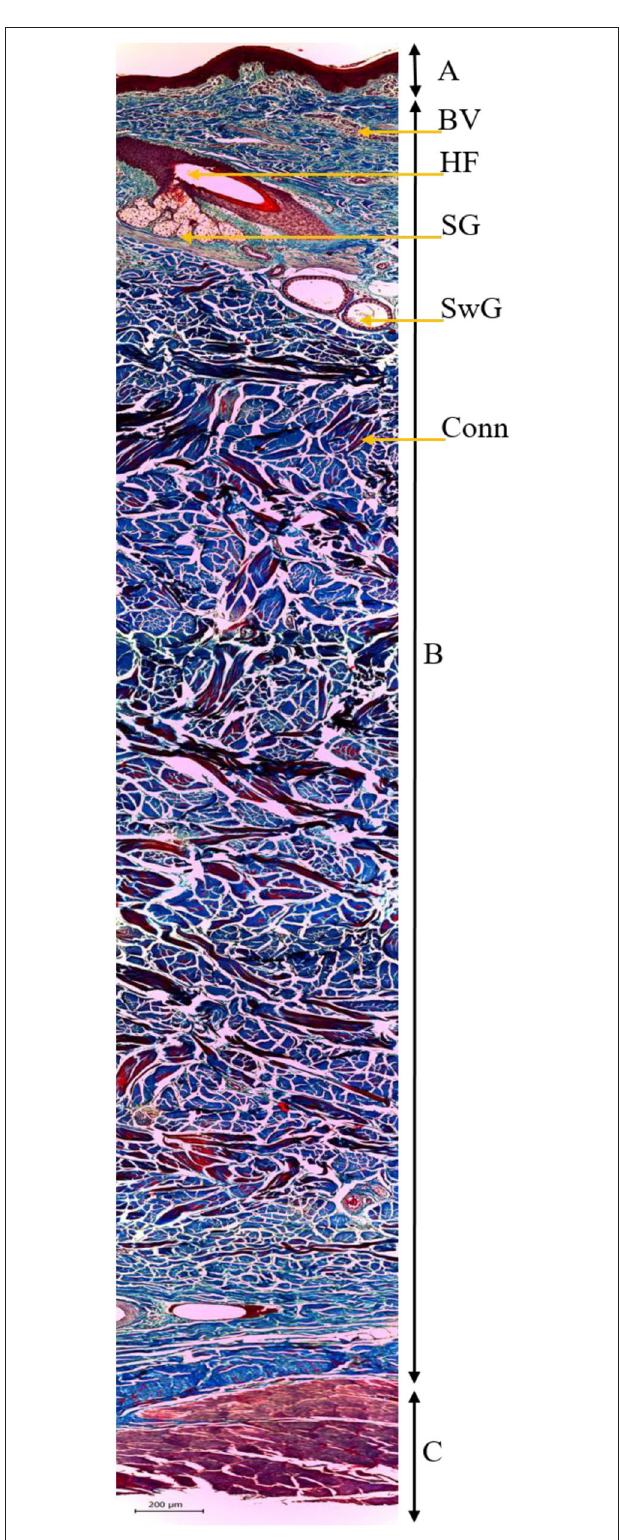
FIGURE 3 | Histological image of the skin of buffaloes ( B. bubalis ) stained by Mason’s trichrome, assessed in light-field optical microscopy (100 × ): epidermis (A) , dermis and hypodermis (B) , and smooth musculature (C) , with emphasis on the identification of the hair follicle (HF), sebaceous glands (SG), sweat glands (SwG), blood vessels (BV), and conjunctive tissue